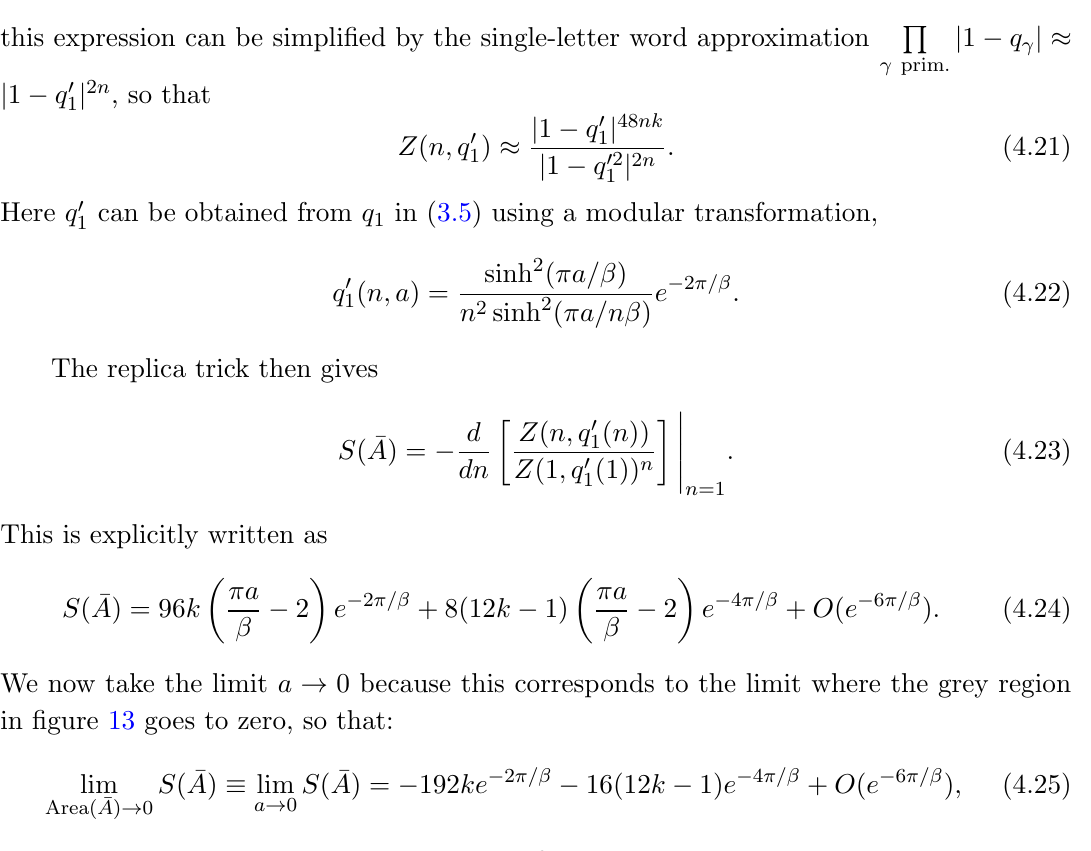
Figure 13 . Left: the complementary bipartition which leads to S (cid:22) a vertical bouquet-like